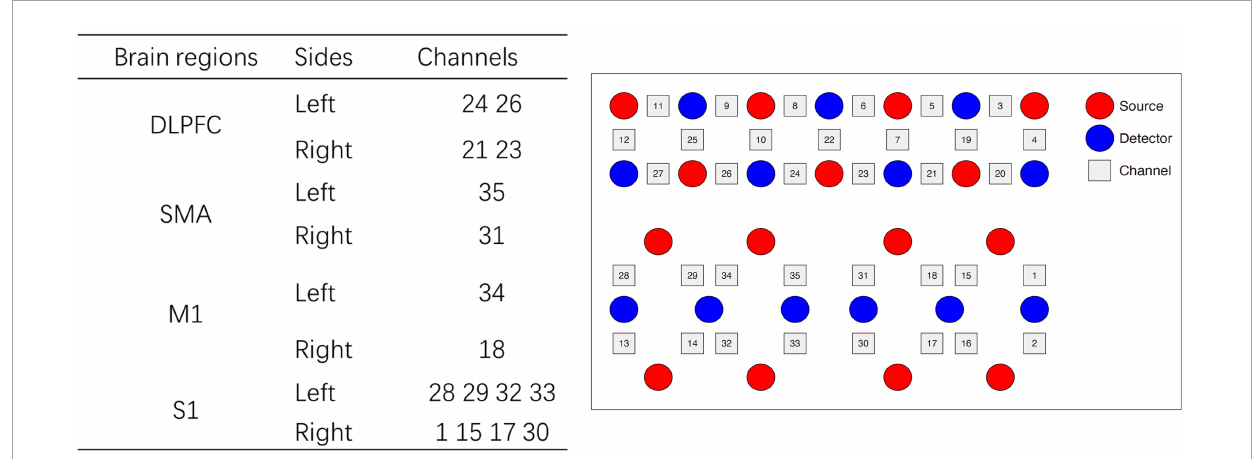
FIGURE1 The configuration of the channel arrangement. DLPFC, dorsolateral prefrontal cortex; M1, primary motor cortex; SMA, supplementary motor area; S1, Primary somatosensory cortex.